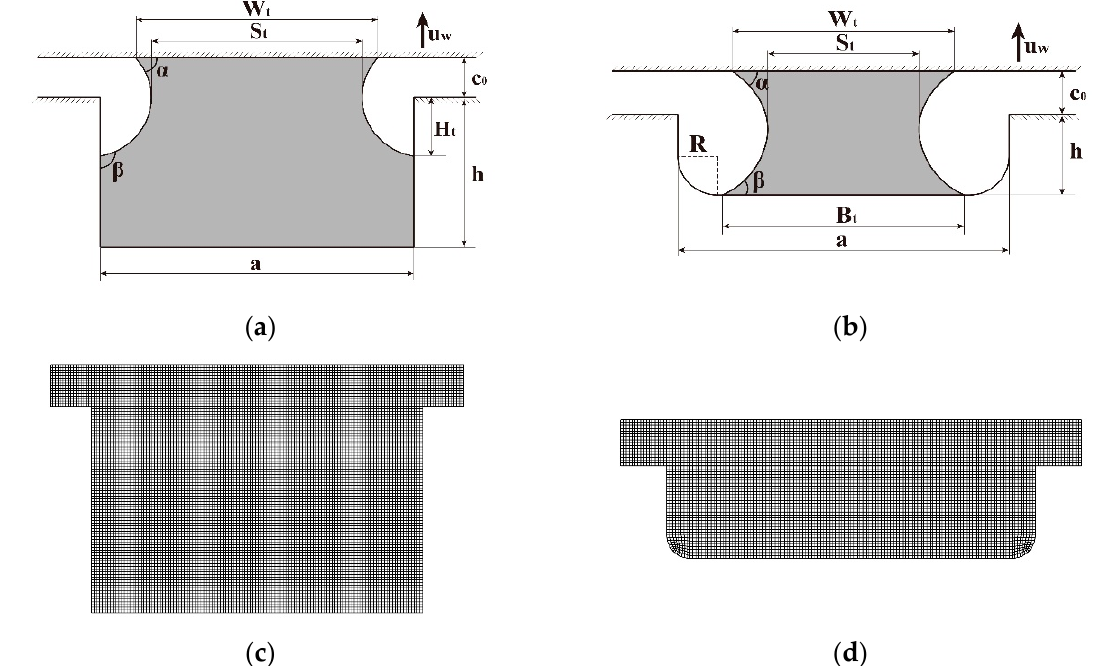
Figure 3. Schematic diagram of simulation model. ( a ) Normal U-shaped cell structure. ( b ) Optimized U-shaped cell structure. ( c ) Computational grid before cell optimization. ( d ) Computational grid after cell optimization.